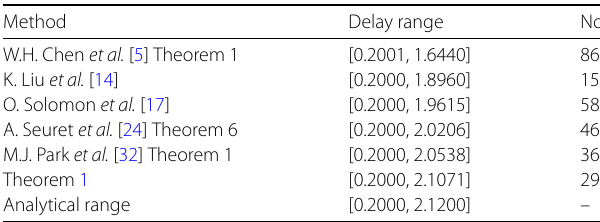
Table 1 The comparison results of time-delay ranges and NoDv (Example 1) Method